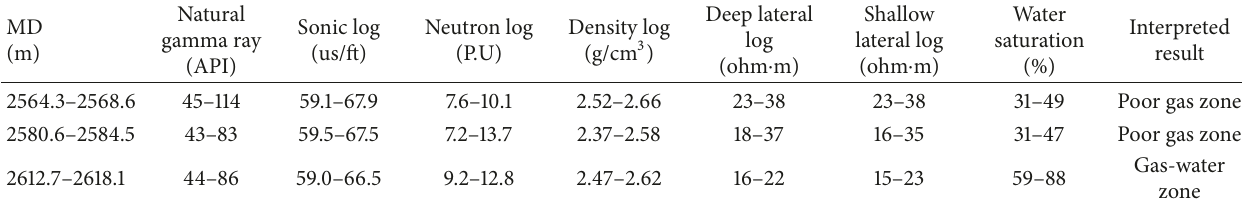
Table 3: Conventional well logs interpretation results for PL113 well